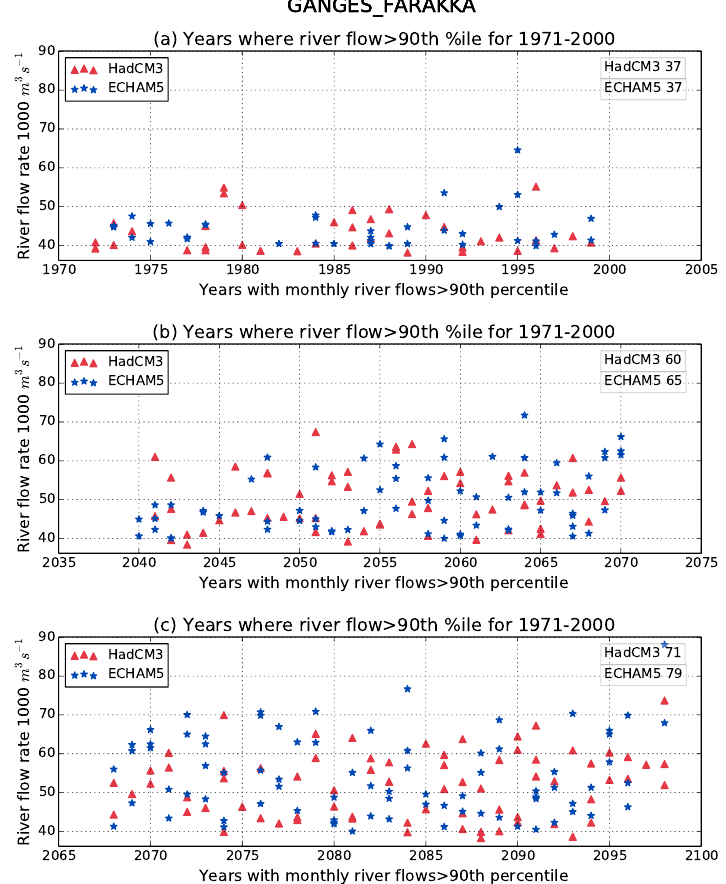
Figure 13. Comparison of the highest 10% of monthly river flows at the Farakka Barrage on the Ganges River against the 90th percentile for the 1971–2000 period for 1971–2000 (top panel), 2050s (middle panel) and 2080s (bottom panel) for HadCM3 (red triangles) and ECHAM5 (blue stars). Each star or triangle represents a month within the 30-year period where the value is greater than the 90th percentile of the 1971–2000 period with the total number for each of the simulations given in the top right corner of each